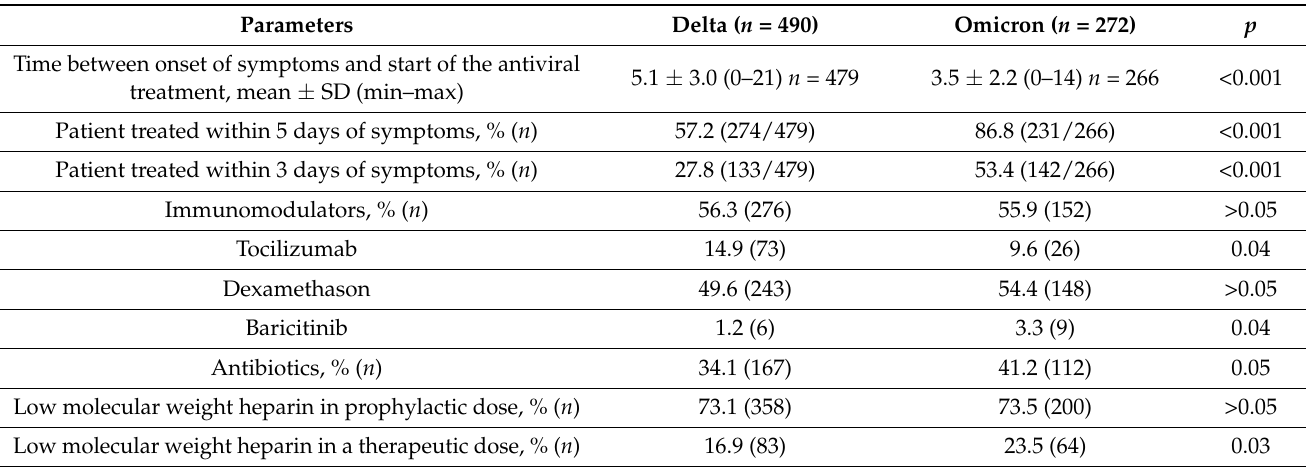
Table 3. Remdesivir therapy and other drugs used in remdesivir-treated patients during Delta and Omicron waves.